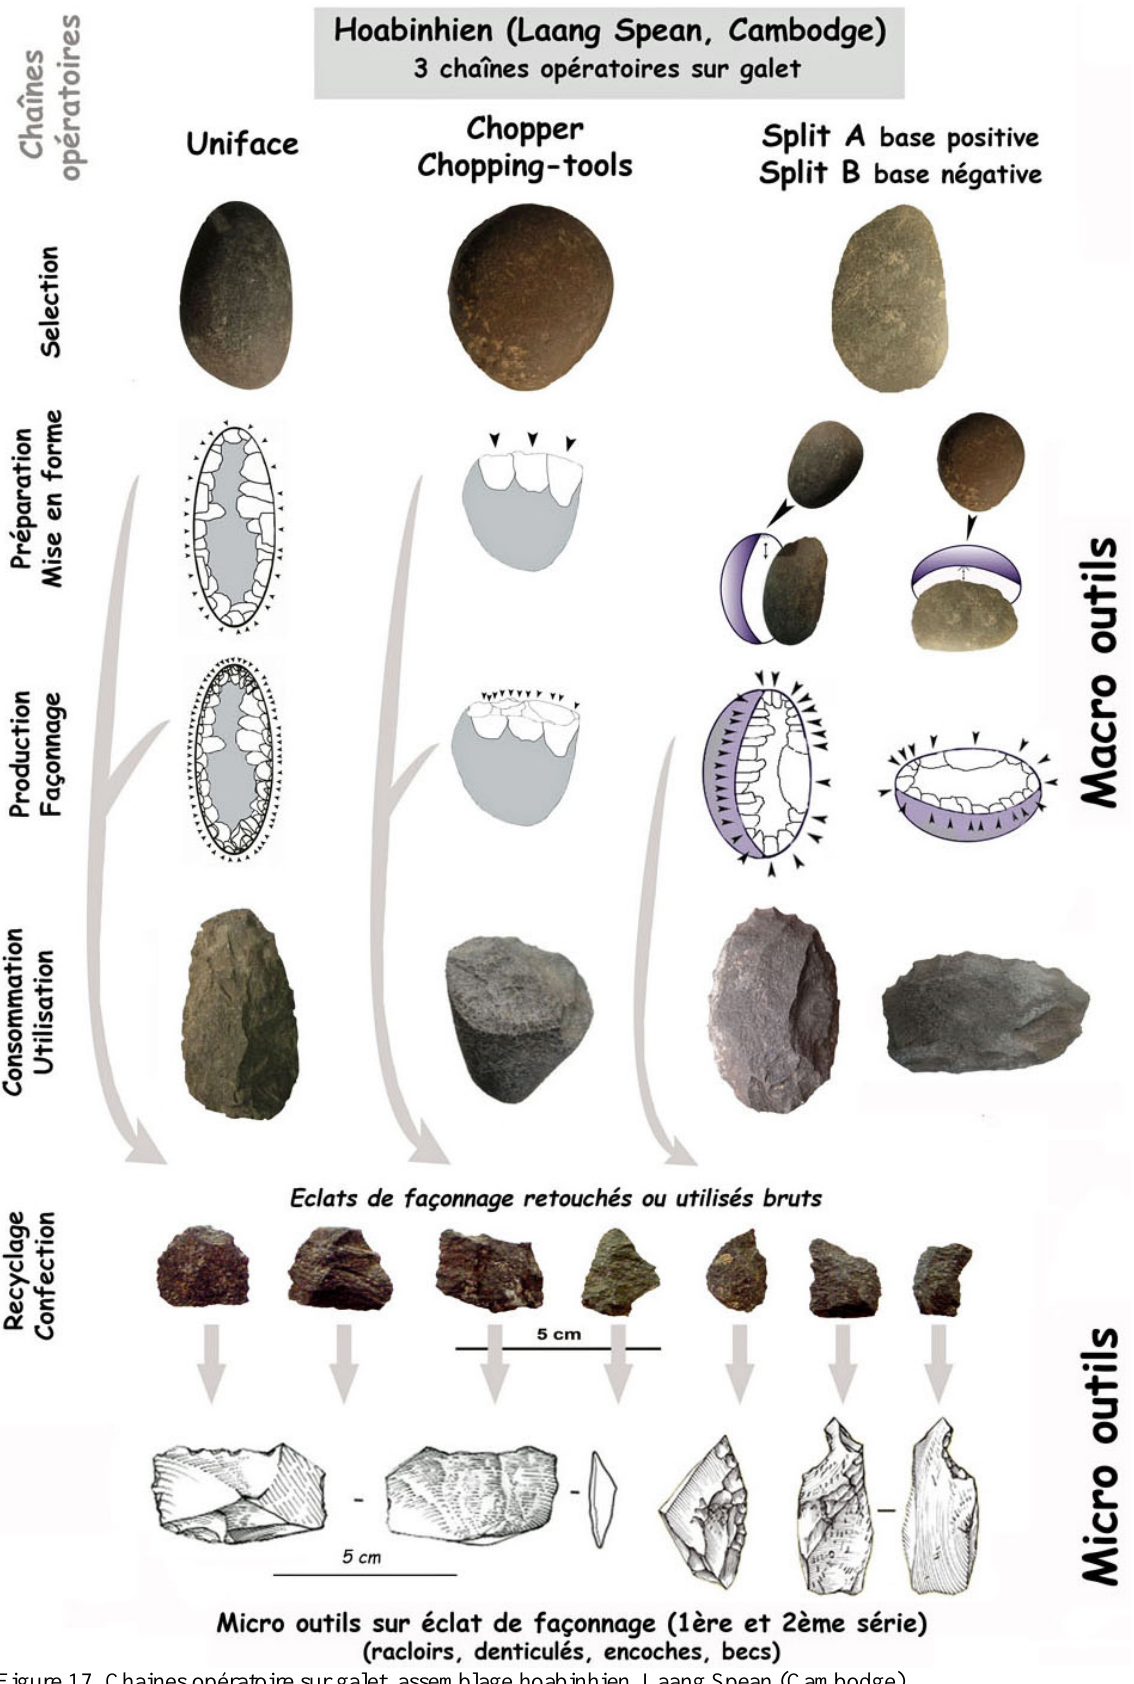
Figure 17. Chaines opératoire sur galet, assemblage hoabinhien, Laang Spean (Cambodge). Figure 17. Chaîne opératoire on pebble assemblage, Hoabinhian, Laang Spean